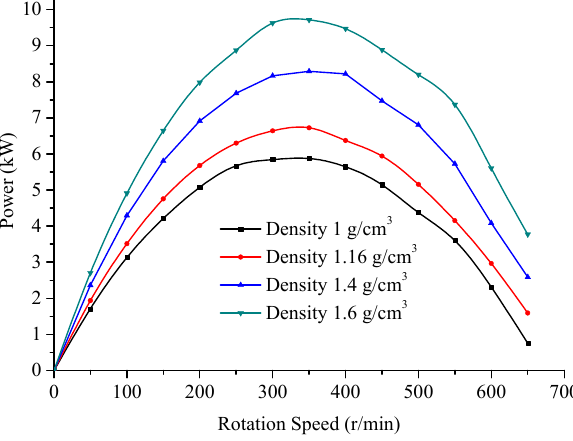
Figure 16. Power vs. speed curves at different densities.